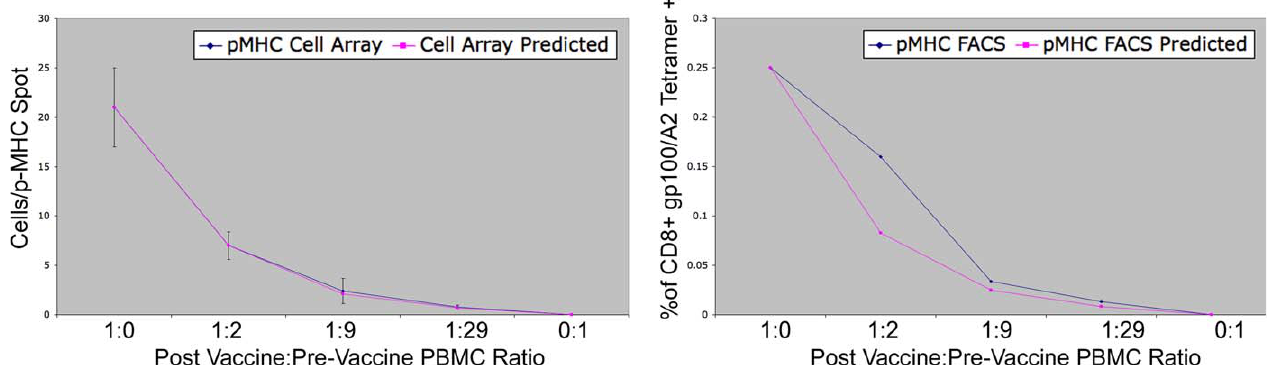
Figure 2. Sensitivity of pMHC-Specific T-Cell Detection The sensitivity of array-based T cell detection was compared to FACS-based detection. Patient PBMCs post-gp100 peptide vaccination were serially diluted in corresponding prevaccination sample. The dilution series was analyzed by both methods. Blue-labeled data correspond to the average number of bound cells per spot on the array (left graph) or the frequency of cells measured by FACS (right graph). The limit of detection in both methods was similar. Average number of bound cells per spot was obtained from five replicate spots on the same array. Error bars denote standard error of the mean across replicates. Red curves denote predicted results based on the values measured for the undiluted sample. DOI: